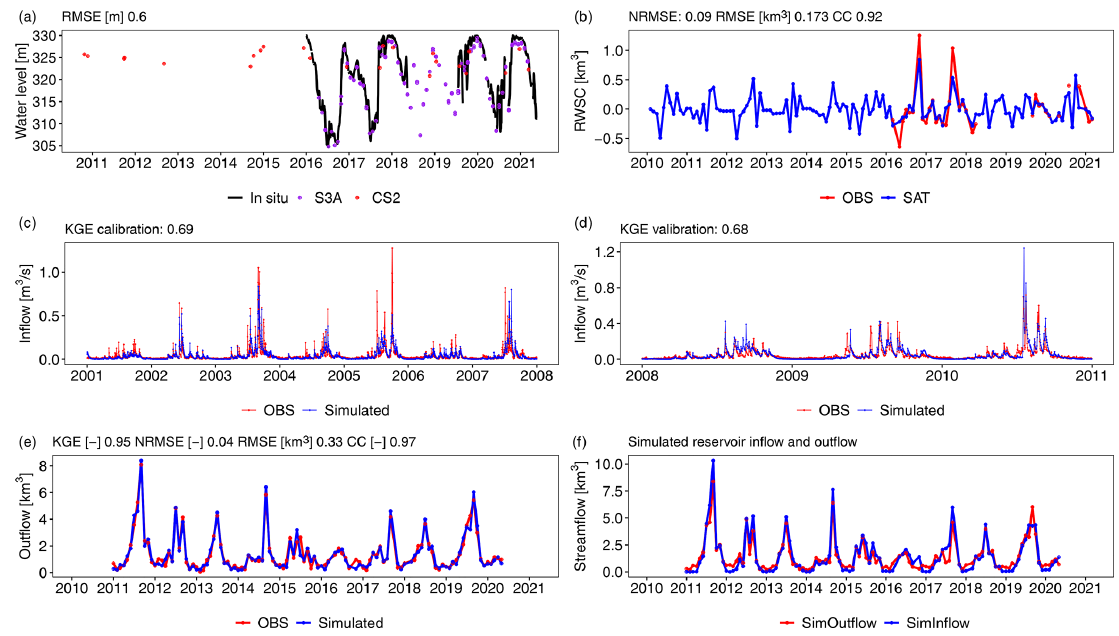
Figure 11. Case study at the Ankang reservoir. Panels (a) and (b) are the evaluation of the remotely sensed WSE and RWSC. Panels (c) and (d) denote the streamflow hydrographs simulated by GR4J model during calibration and validation periods. Panel (e) represents the comparison of model-simulated outflows and gauged records. Panel (f) shows streamflow regulation by reservoirs. Note that only historical inflow records before 2010 are available in this